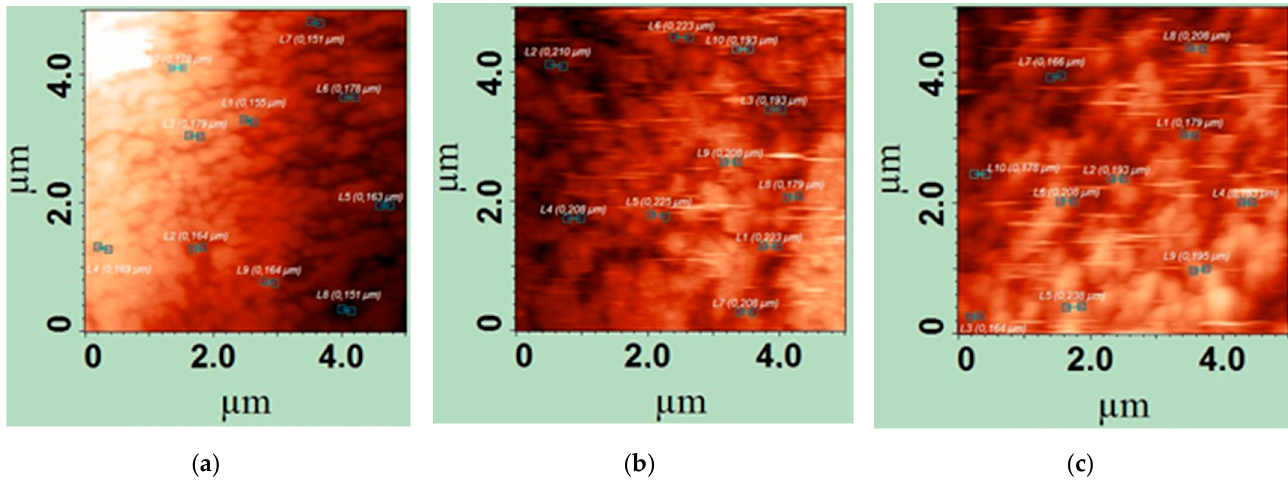
Figure 3. Images of the surface of phosphate coatings from the SolverP47-PRO atomic force micro- scope: ( a ) Coating from a modified solution; ( b ) Coating from a solution with the addition of zinc nitrate; ( c ) Coating from a solution with the addition of calcium nitrate.